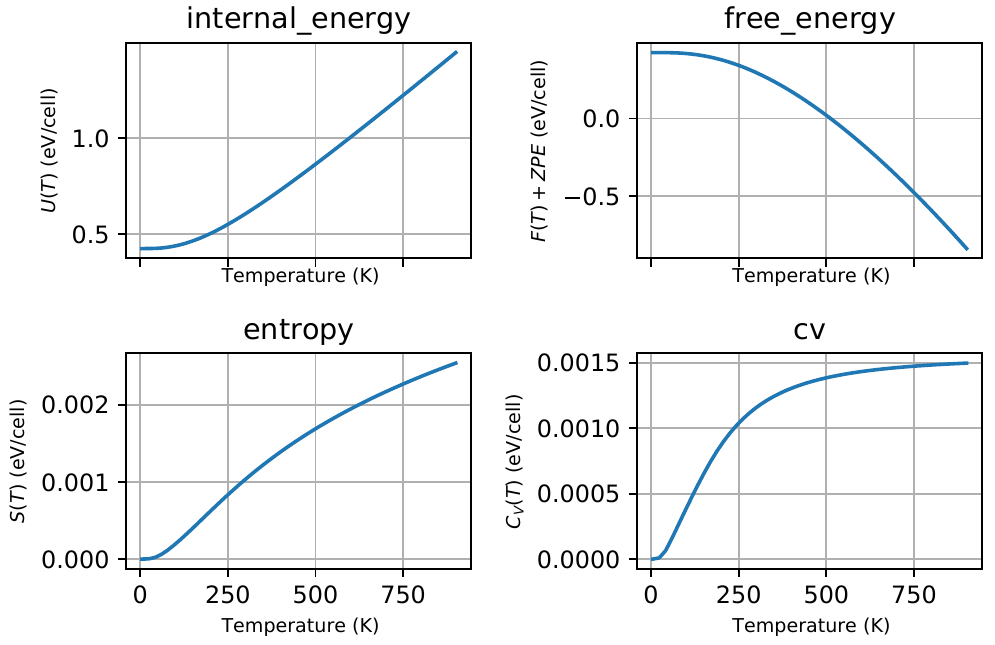
Figure 7. ZrB 2 ( oP6 -P6/mmm-space group, no.59)-thermodynamic properties: internal energy, free energy, entropy and constant-volume specific